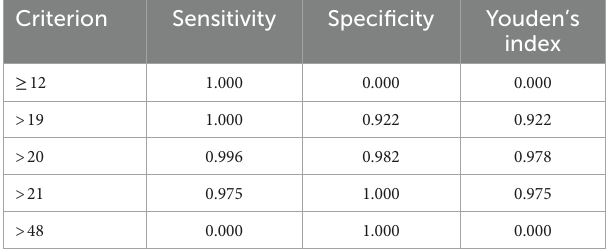
TABLE 8 Criterion values and coordinates of ROC curve for perceived COVID-19